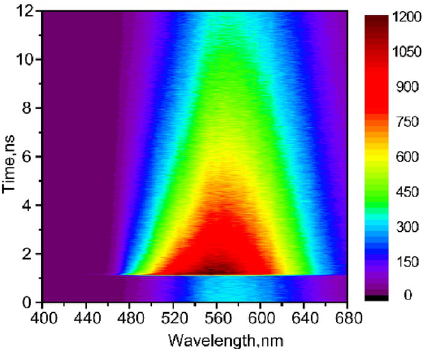
Figure 2. Time-resolved fluorescence map of perylene film, measured by TCSPC, λ ex = 250